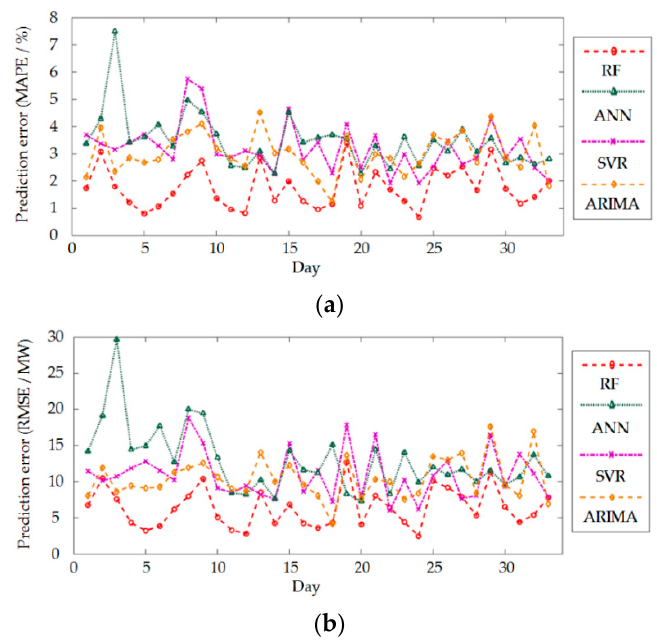
Figure 10. ( a ) MAPE of four predictors for each test day when day ‐ ahead prediction is conducted; ( b ) RMSE of four predictors for each test day when day ‐ ahead prediction is conducted.